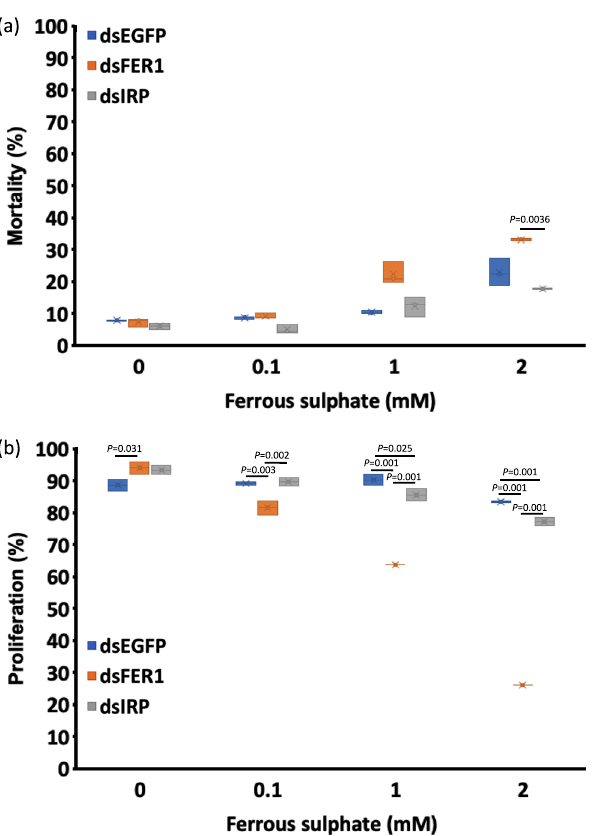
Figure 5. ISE6 cells were exposed to 800 ng of dsRNA for 48 h and transfected using HilyMax. Two hundred and fifty microliters of 1 × 10 6 silenced ISE6 cells/ml was transferred to a 48-well plate and incubated overnight. The next day, the media were replaced by iron-enriched media at different concentrations of 0, 0.1, 1, and 2 mM ferrous sulphate. ( a ) Box and whisker plot showing the distribution of the mortality of the ISE6 cells in percentage using Trypan blue stain at different time points. A Kruskall –Wallis test with Bonferonni multiple comparison tests was performed to analyse the mortality data (Tables S14 and S15). ( b ) Box and whisker plot showing the distribution of the proliferation rate in percentage of ISE6 cells using MTT assay at different time points. A one-way ANOVA with Bonferonni multiple comparison tests was performed to analyse the proliferation rate data (Tables S17 and S18). The data presented are results of three independent experiments with the Trypan blue and MTT assays performed in two technical replicates for each